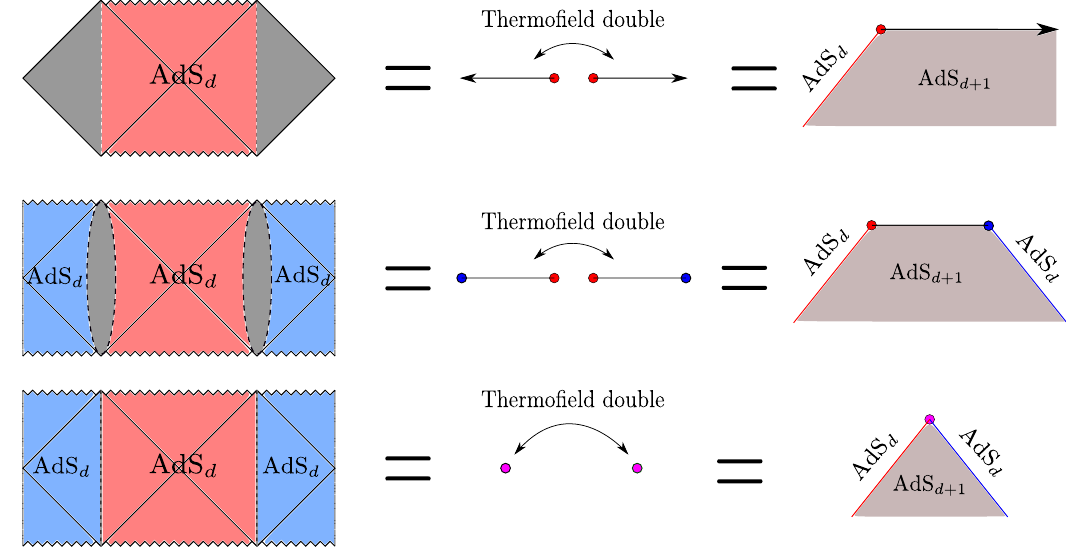
Figure 5 . We represent wedge holography as a series of modifications to the familiar example of the top line [5, 36, 50–52]. On the top left we have the spacetime for the eternal black hole in AdS d coupled to two flat space baths. There is a holographic CFT everywhere in the spacetime. The top d middle represents the microscopic description, where we have a holographic CFT (represented d − 1 by a red dot) coupled to a d -dimensional bath hosting the holographic CFT , and this joint system’s d thermofield double partner. The top right illustrates the emergent ( d + 1) -dimensional description (the thermofield double part is not represented for simplicity). In the middle line we have the same representations, except we now have a finite bath and an additional holographic CFT d − 1 (represented by a blue dot) which is also coupled to the bath CFT (and their thermofield double d partners) [53, 54]. The Penrose diagram is identified at the left and right. The final line shrinks the bath size to zero, so the interacting CFT’s sit right on top of one another [4, 55]. Notice in this case the boundary dual has spacetime to both sides. In our de Sitter analogy this will be the primary feature we are interested in, as our “boundary dual” is on the cosmic horizon and has spacetime to both sides. The analog of the doubly emergent AdS will not play a d +1